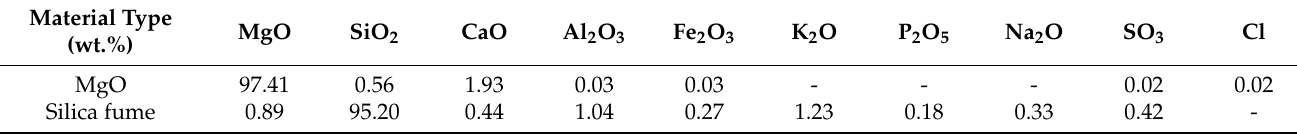
Table 1. Chemical compositions of the raw materials